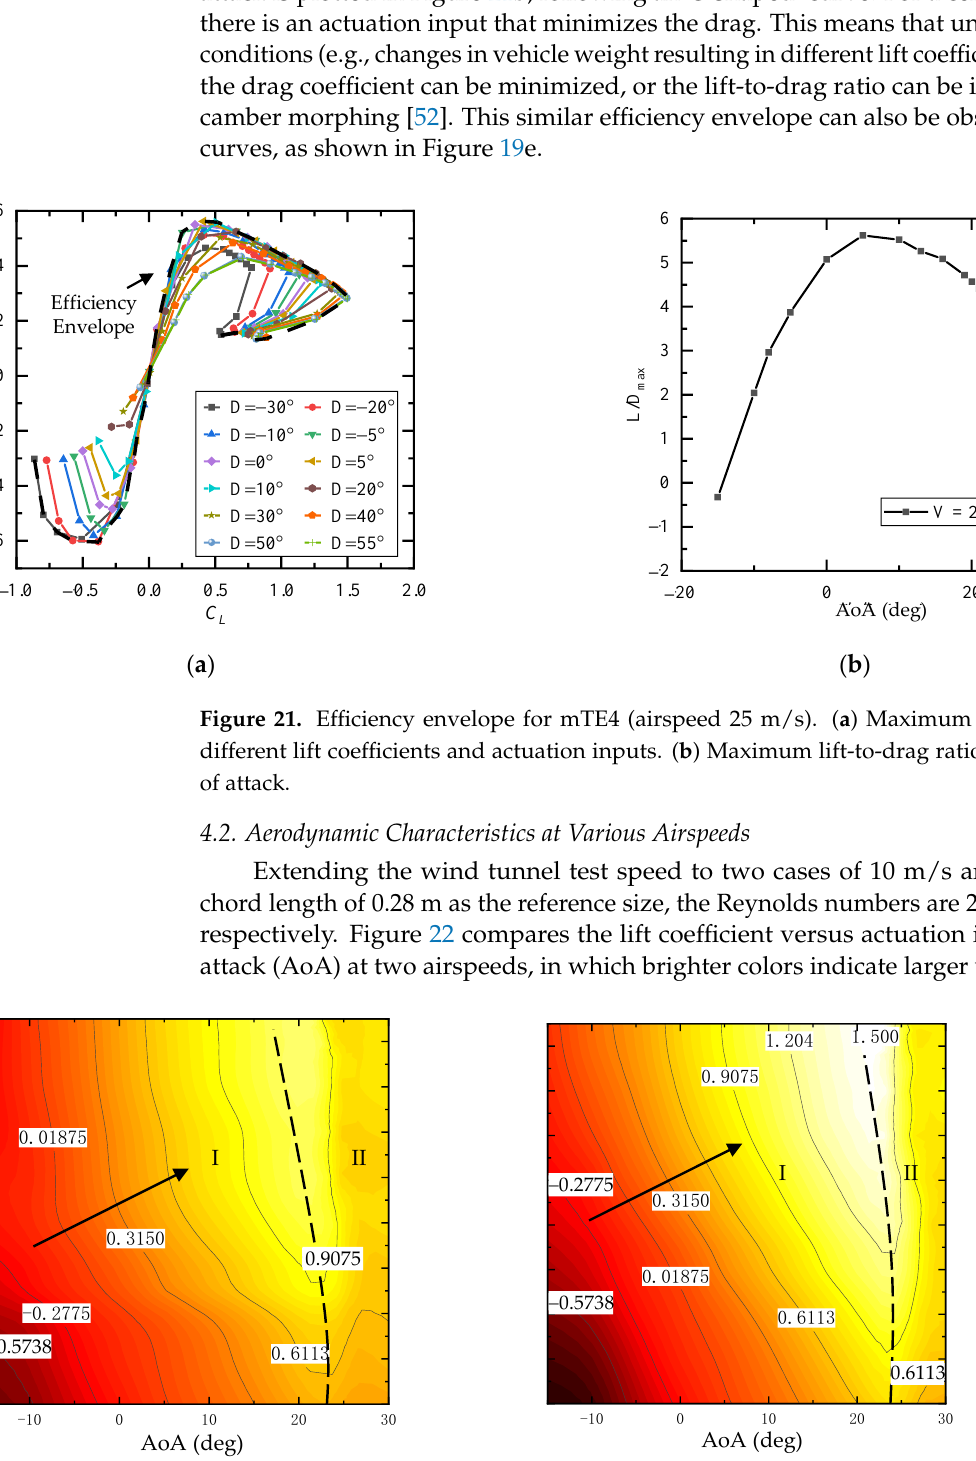
Figure 22. Lift coefficient versus AoA/actuation input for mTE4 at different airspeeds. ( a ) Airspeed 10 m/s. ( b ) Airspeed 25 m/s.